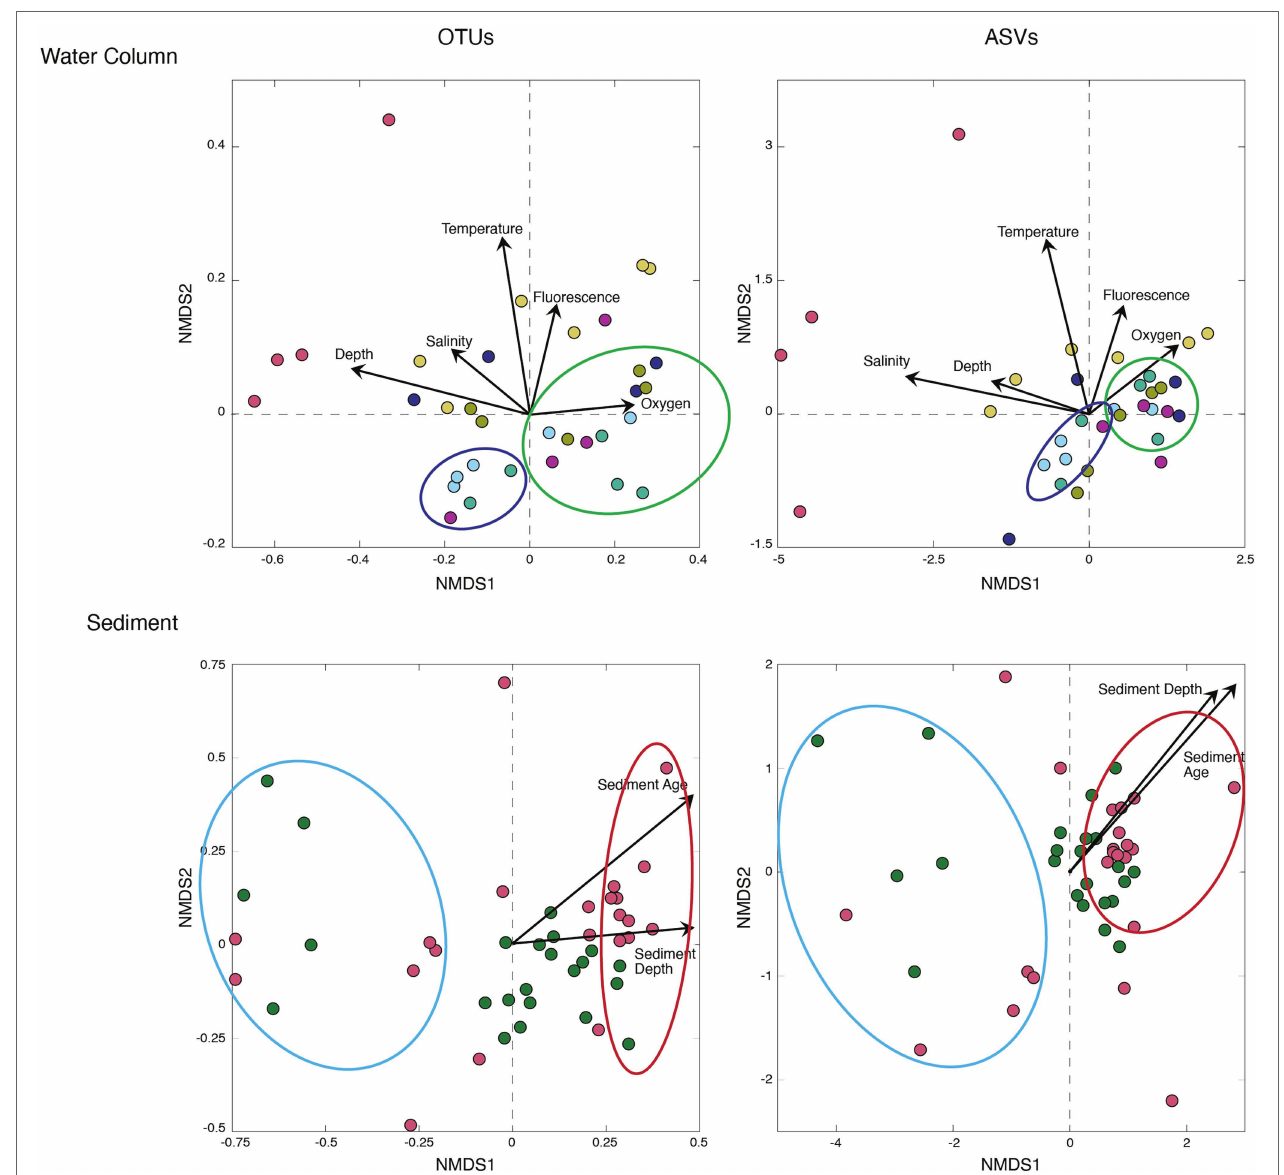
FIGURE 5 | Bray–Curtis Nonmetric Multidimensional Scaling (NMDS) of the water column (top) and marine sediment (bottom). All Arctic samples exhibit similar groupings, and only four of the nine Arctic sites are presented here for ease of visualization. Sample colors correspond to sample sites plotted in Figure 1 . OTUs (left) and ASVs (right) are overlayed with environmental factors for both the water column (salinity, temperature, fluorescence, and oxygen) and sediment (sediment depth and sediment